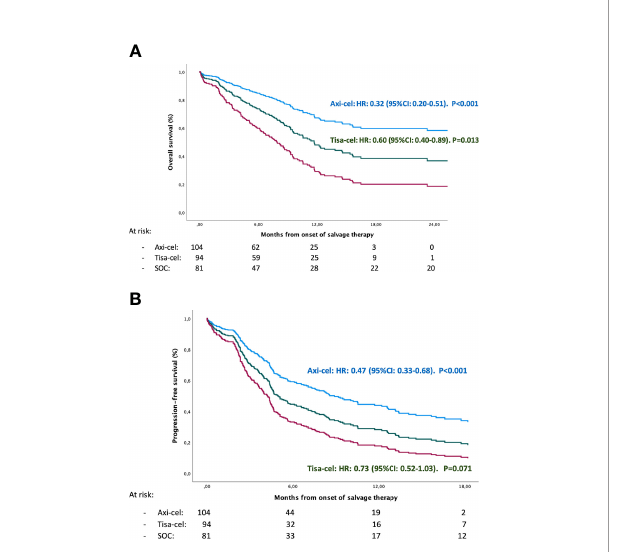
FIGURE 2 | Overall survival (A) and progression-free survival (B) comparing: Axi-cel vs Tisa-cel vs previous Standardregression of care (pSOC) adjusted using a multivariable Cox regression